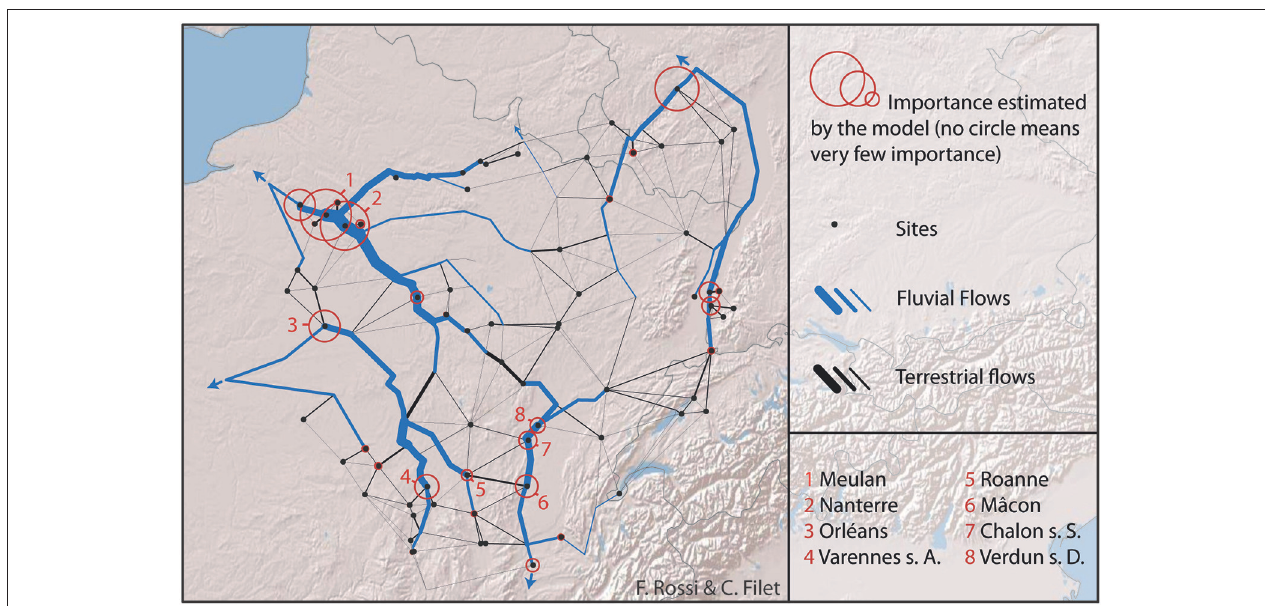
FIGURE 2 | Exemplary output for settlements of more than 7 ha and dated from LT D1. Created by author (Basemap: Copyright © 2017 Esri. All rights